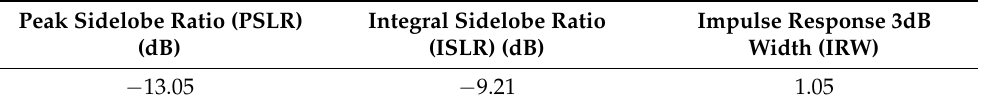
( b ) Figure 19. Airborne SAR real-time imaging results. ( a ) Matlab process result. ( b ) FPGA process result. Table 6. Result of the test image.